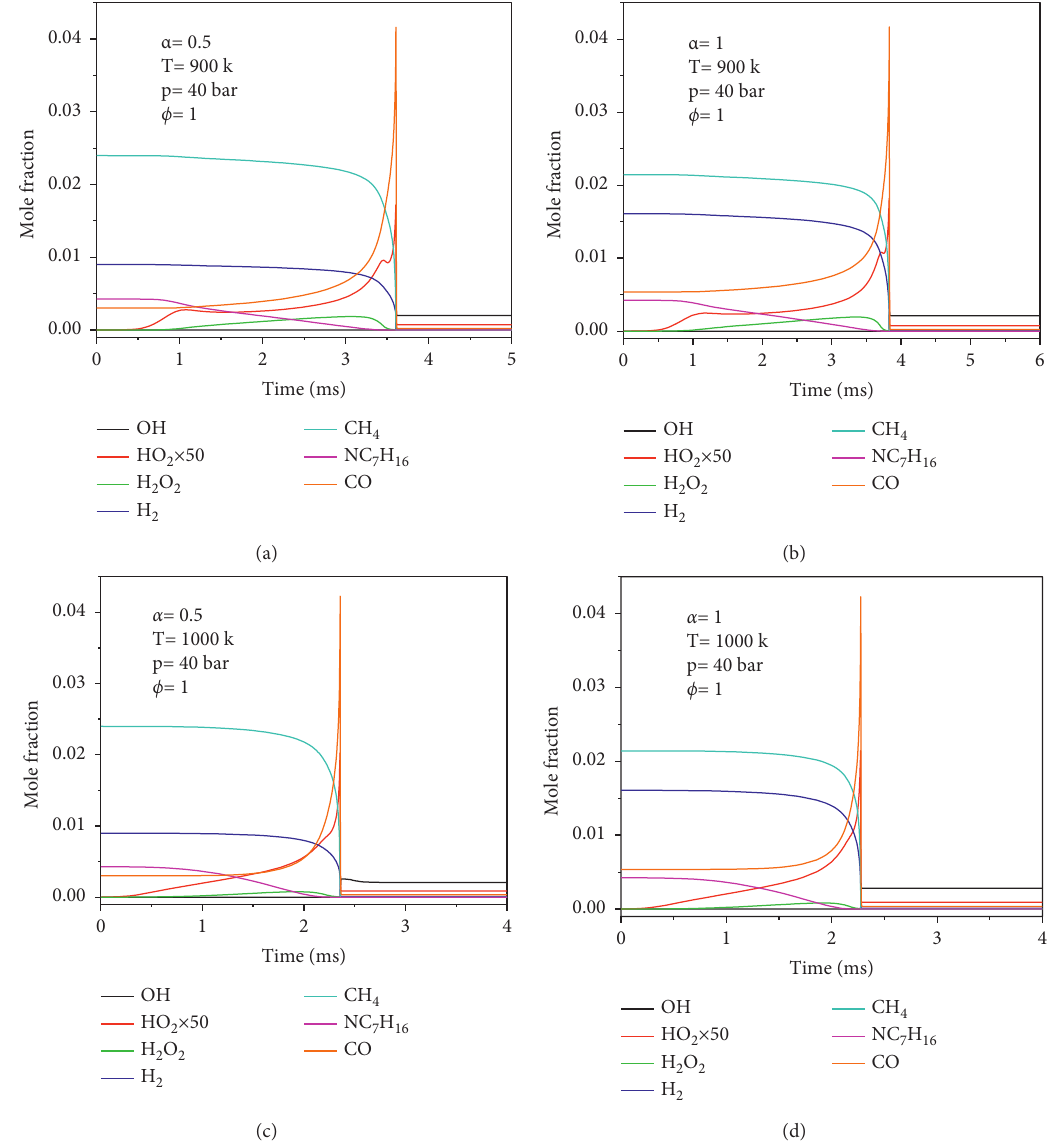
Figure 12: Effect of initial temperature and α on species evolution for methane/H